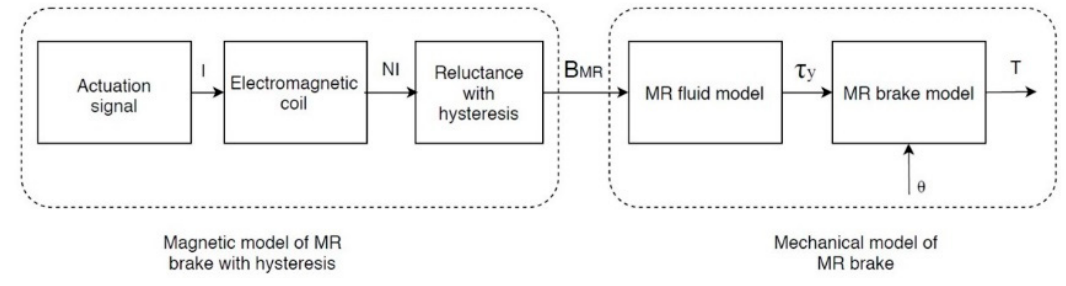
Figure 1. Block diagram of the simulated model.